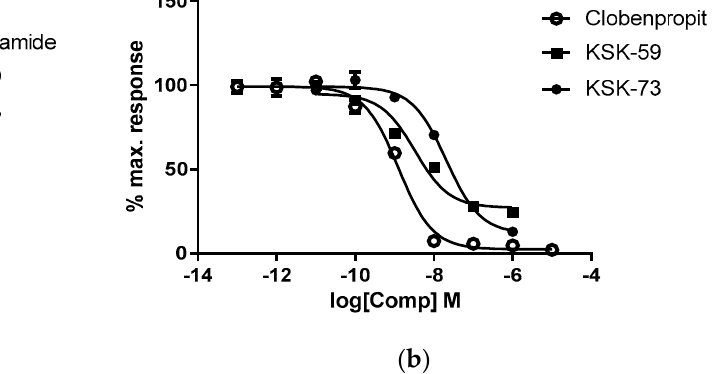
Figure 1. The intrinsic activity at H 3 histamine receptor of the tested compounds presented as a concentration-dependence curves. ( a ) Lance cAMP, ( b ) Aequoscreen. Obtained values (%) are expressed as percent of the action of full agonist ( R )-alpha-methylhistamine at the dose of EC 80 (100%). Table 2. The results obtained in